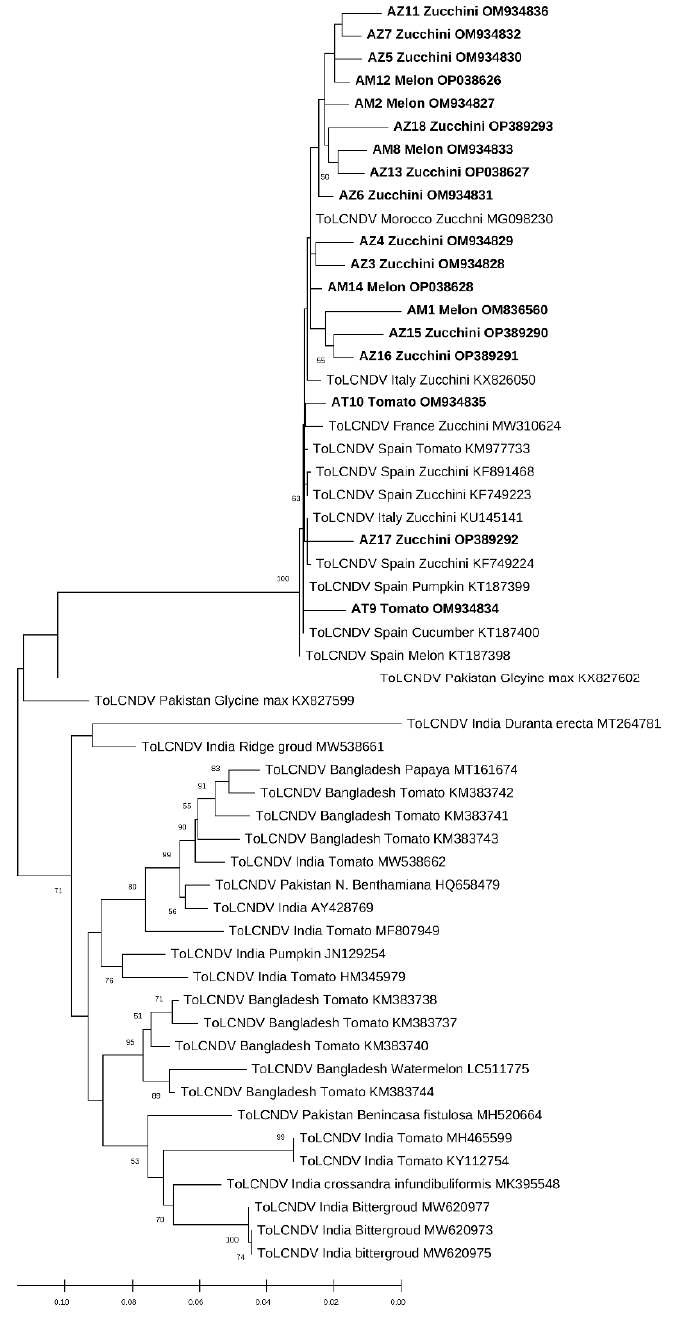
Figure 5. The evolutionary history was inferred by using the Maximum Likelihood method and the Kimura 2-parameter model for the ToLCNDV. This analysis involved 55 nucleotide sequences for the ToLCNDV; only the results that have branch support above 50% are shown.